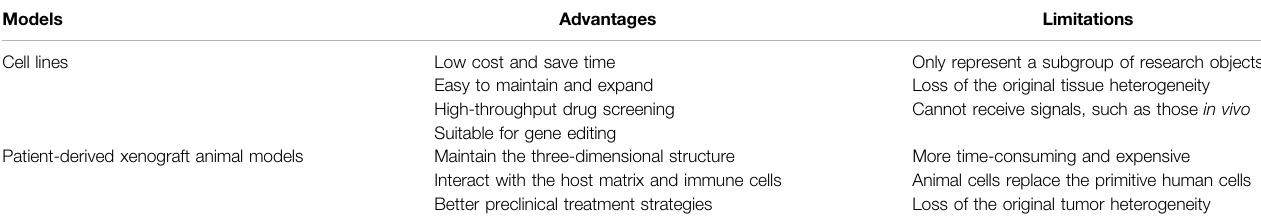
TABLE 1 | Advantages and limitations of cell lines and